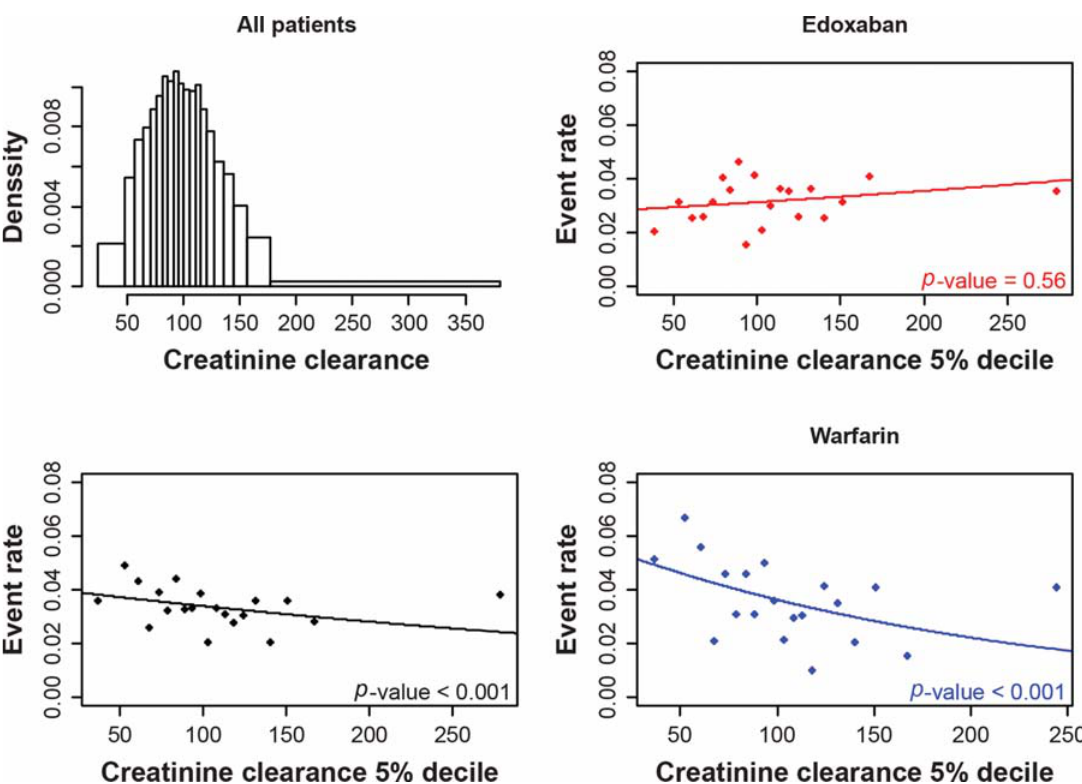
Fig. 2 The distribution of creatinine clearance and the relationship between VTE recurrence and creatinine clearance, overall and by treatment arm. VTE, venous thromboembolism.